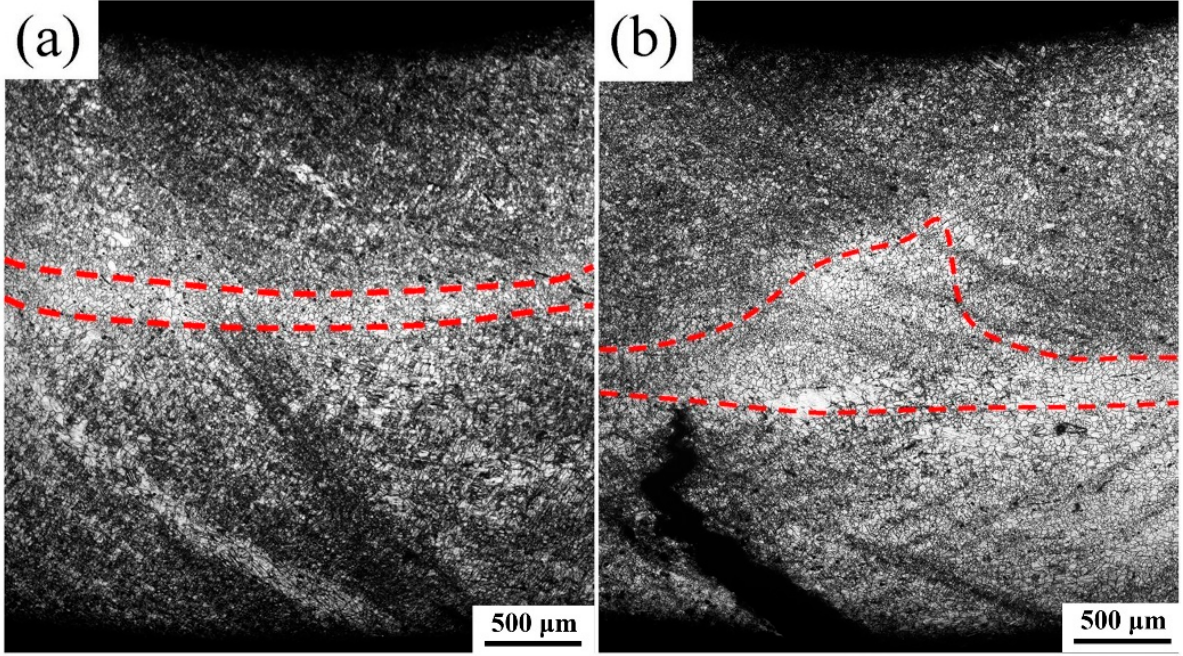
Figure 4. Optical micrographs ( a ) of the side surface (position I in Figure 3i) and ( b ) middle symmetrical surface (position II in Figure 3i) perpendicular to the transverse direction (TD) of the sample when the bending test interrupts at the punch stroke of 3.0 mm.